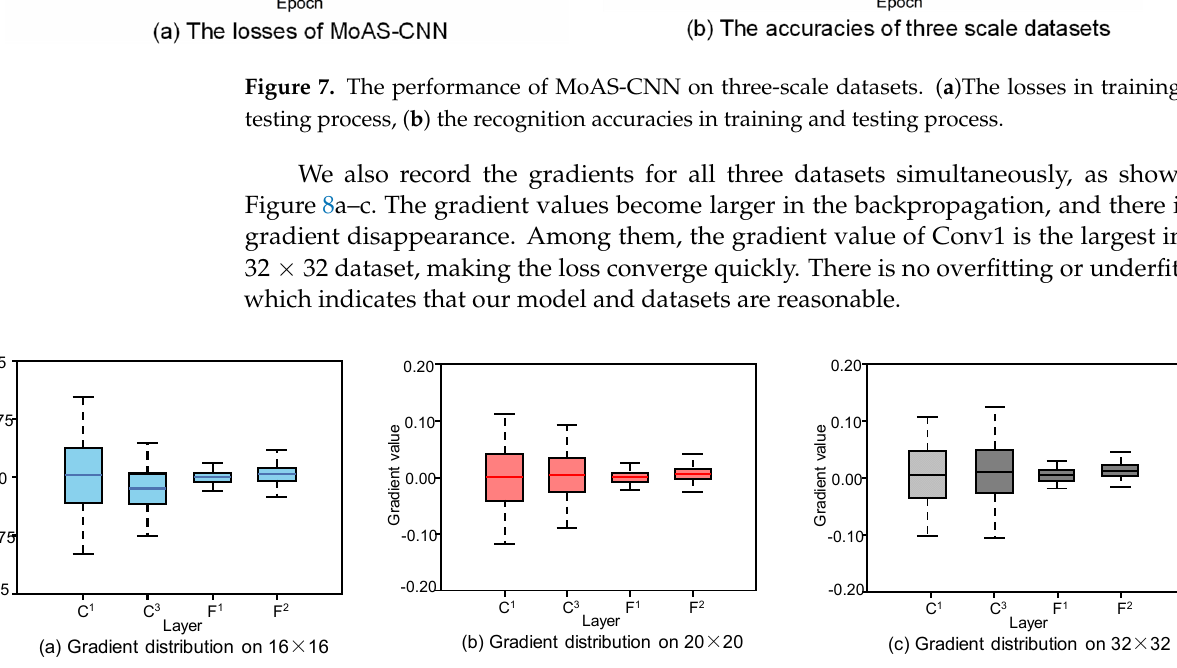
Figure 8. Gradient distribution on 16 × 16, 20 × 20, 32 × 32 datasets during training.